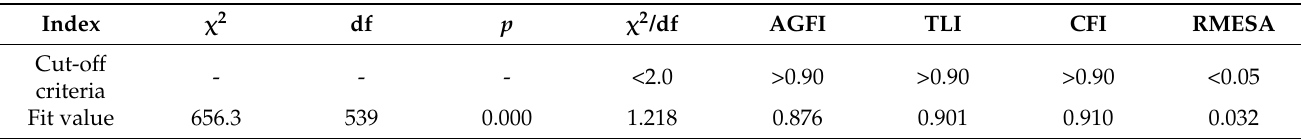
Table 1. Goodness of fit of the measurement